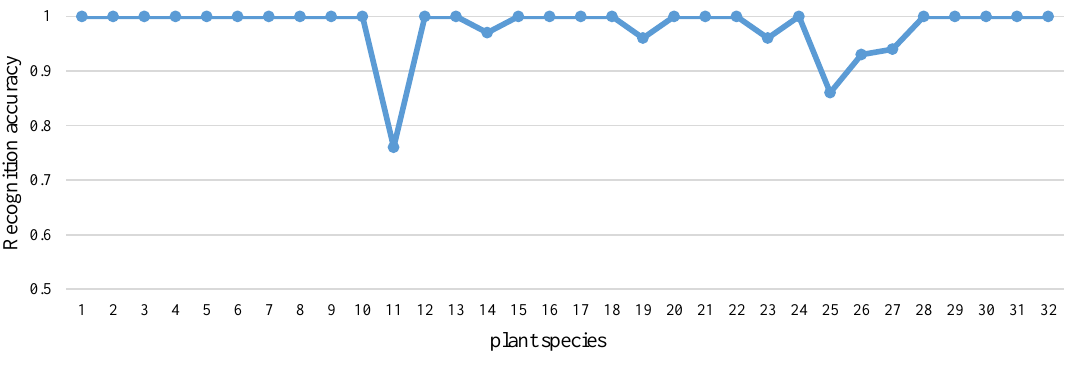
Figure 13. The recognition accuracy of each species in the Flavia dataset.